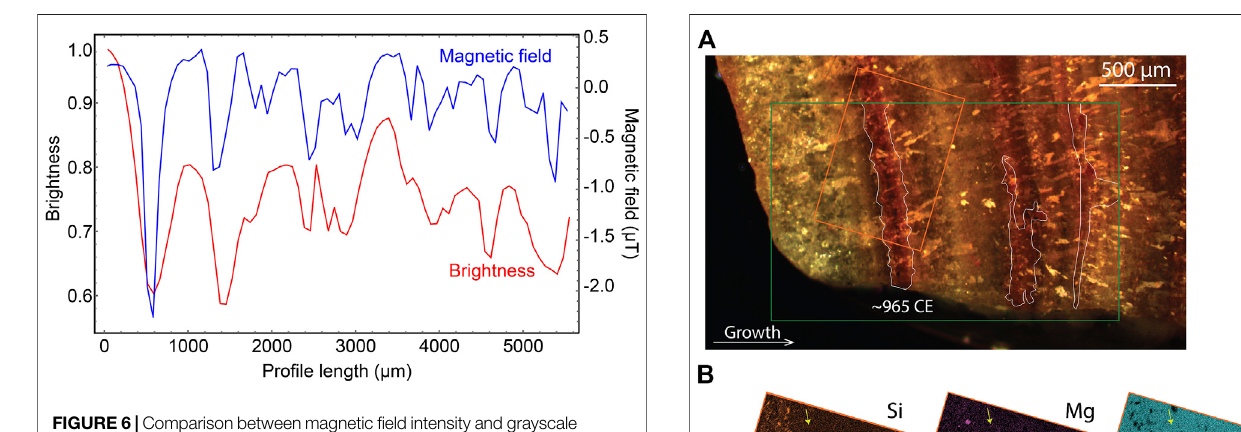
FIGURE 6 | Comparison between magnetic fi eld intensity and grayscale brightnessover thefullQDM mapped pro fi le withtime progressing toward the right. The brightness levels have been normalized such that the maximum value is one and black is 0. Note that more negative values of magnetic fi eld correspond tostronger magnetization duetothe negative directionofthe applied IRM. Both datasets have been binned in 48 µm intervals. Values on x -axis denote distance from the youngest end of the mapped pro fi